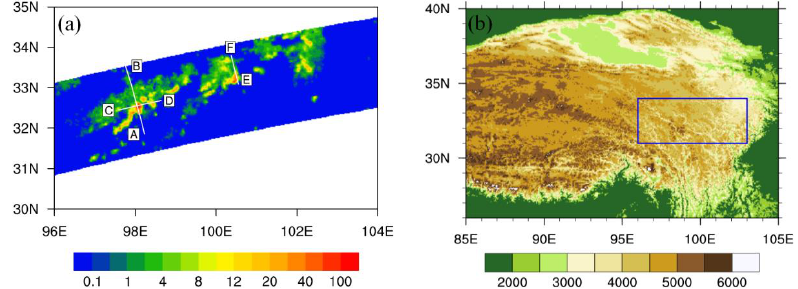
Figure 3. ( a ) Distribution of near-surface precipitation rate (units: mm·h −1 ) over the southeastern Tibetan Plateau on 5 August 2014 (12:26 UTC); ( b ) Elevation map (units: m) of the Tibetan Plateau. The blue box is the precipitation area detected by TRMM PR.